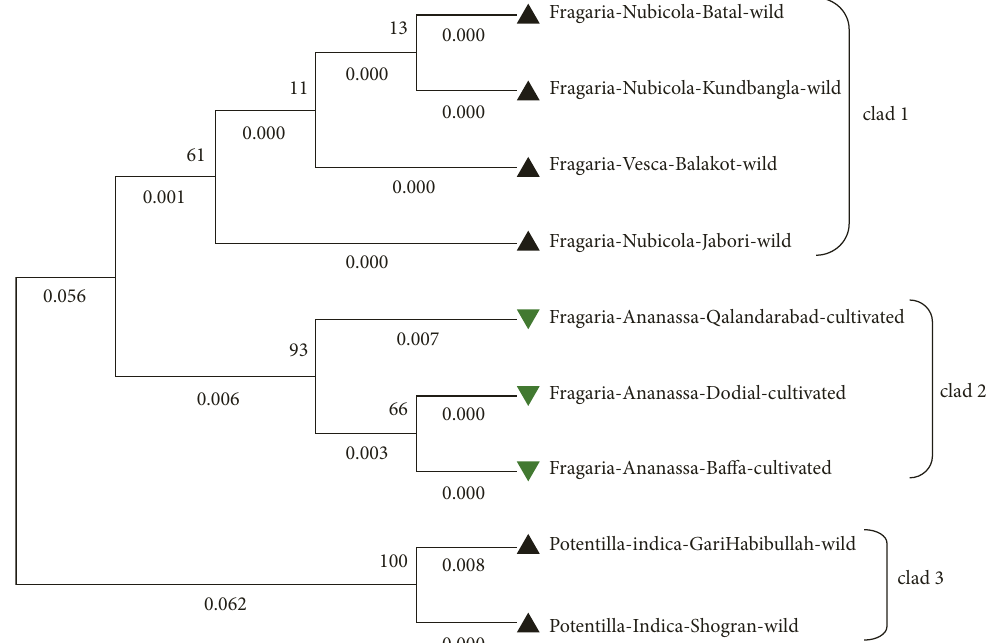
Figure 6: Phylogenetic tree among wild and cultivated Fragaria species of the ITS2 marker through the neighbor-joining